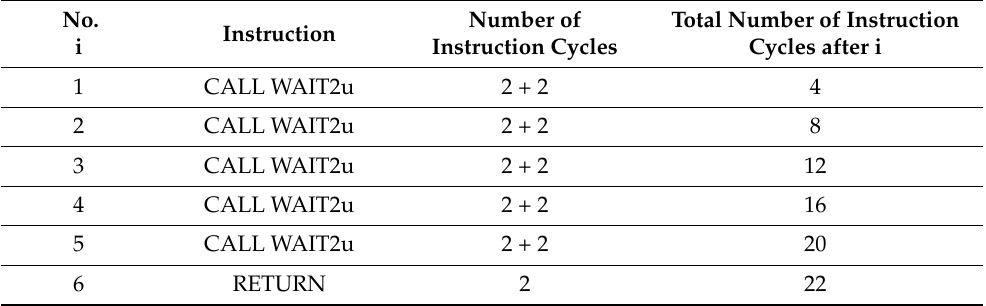
Table 4. Subroutine for 10 µ s time delay.